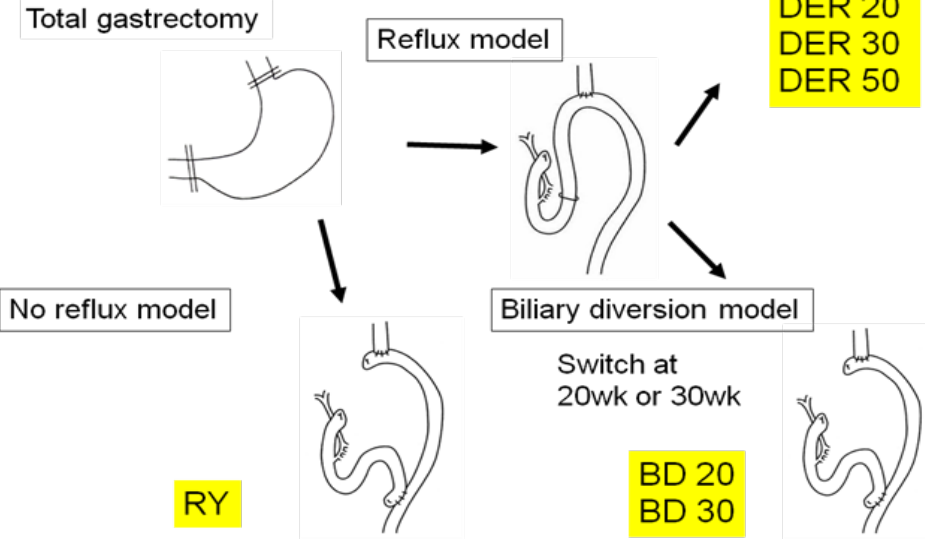
Figure 8. All animals first received total gastrectomy. (1) The DER 20, DER 30, or DER 50 group was reconstructed by esophagojejunostomy to induce the DER (Figure 2b), followed by killing after 20, 30, or 50 weeks, respectively; (2) biliary diversion (BD) procedure, converted from the same DER operation (Figure 2b) to the RY method (Figure 2d), to avoid bile regurgitation into the esophagus at week 20th (BD 20) or week 30th (BD 30), followed by euthanasia at 50 weeks after initial operation; or (3) The RY group was reconstructed by RY method (Figure 2 d ), followed by killing after 50 weeks served as